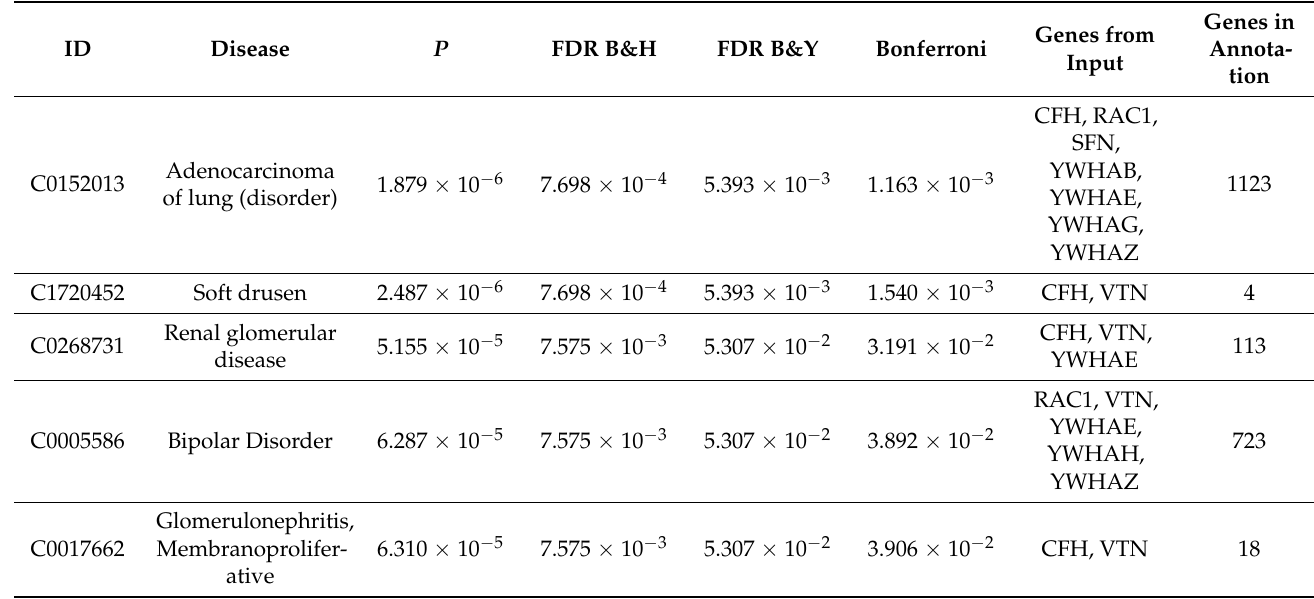
Table 4. The top 5 annotations of the ToppFun FEA relative to